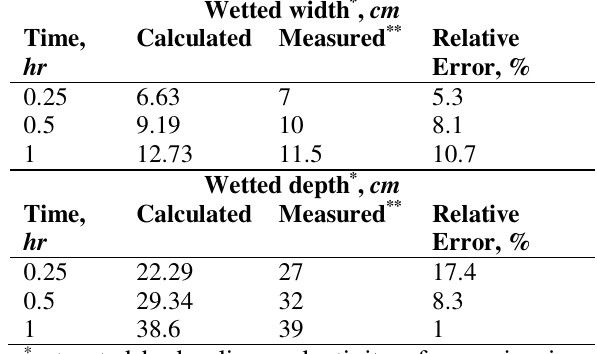
distribution through two types of soils (sand and formulas for wetted width and depth as a